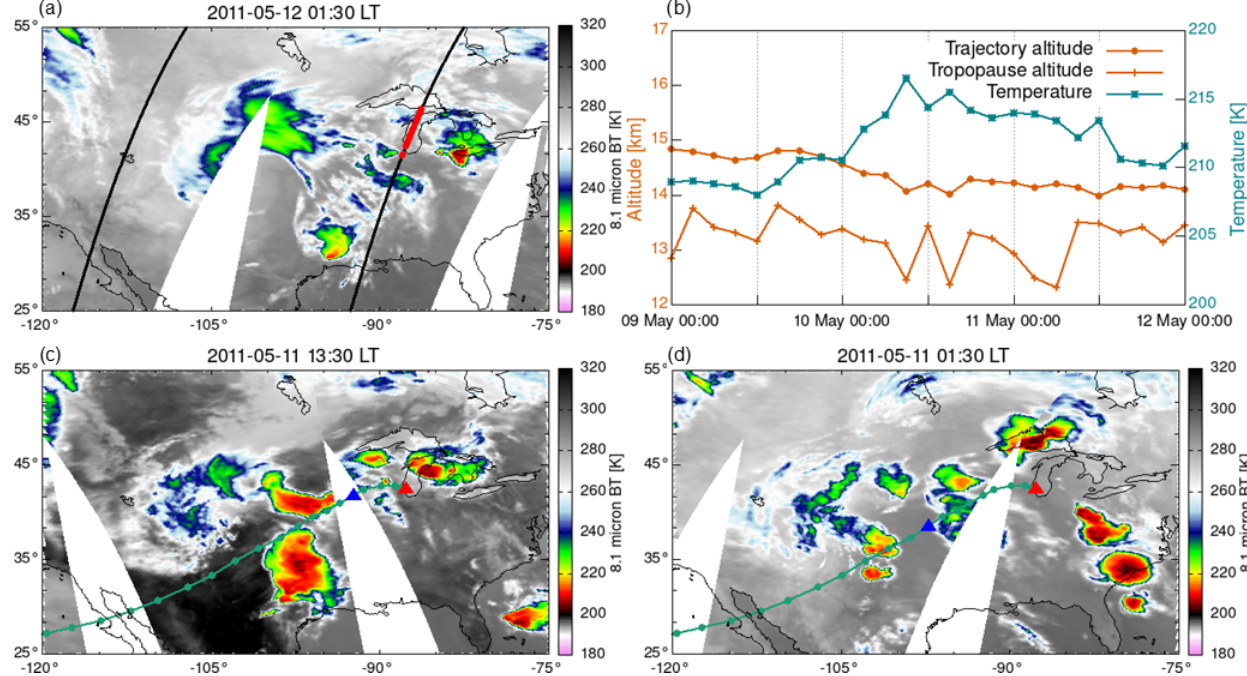
Figure 8. CALIPSO SIC (red dots) and AIRS deep convection (colours) observations. (a) The observed SICs on 12 May 2011 are unrelated to local deep convection. (b) The trajectory height, tropopause height, and trajectory temperature along a 3d backward trajectory. (c, d) The trajectory (green dotted line with a time interval of 3h) starting at an SIC observation (red triangle) passes deep-convection systems approximately several hours earlier on 11 May 2011. The blue triangles indicate the position of the air parcel at local time 13:30 and 01:30 on 11 May